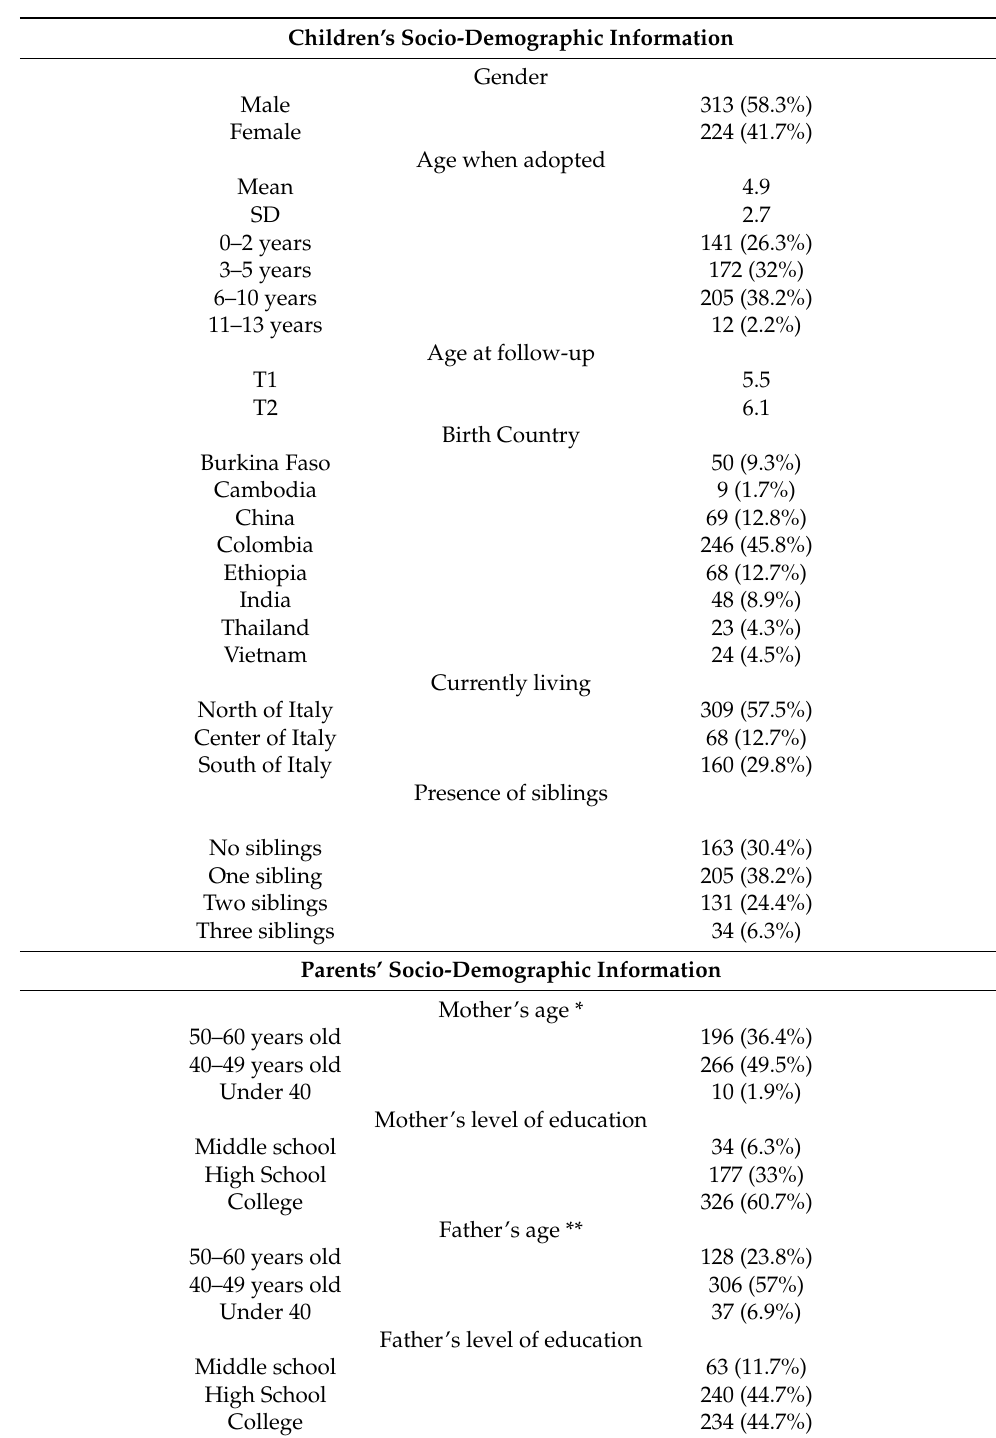
Table 1. Sociodemographic information ( N =